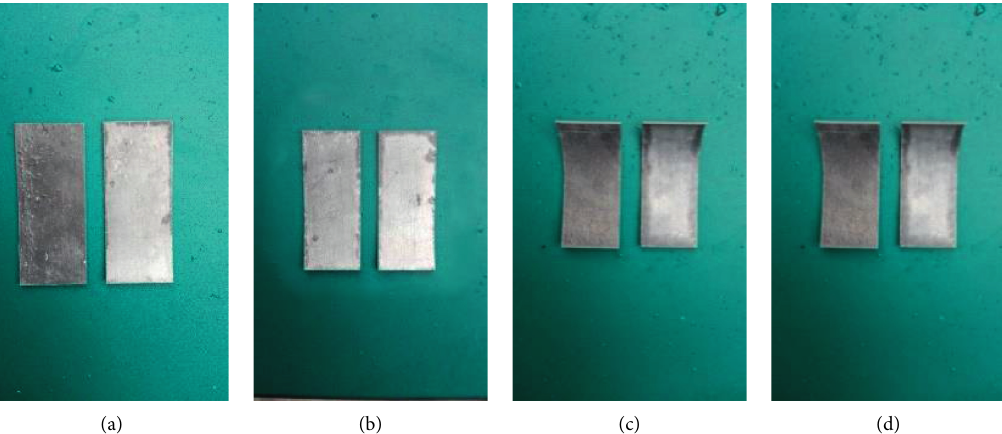
Figure 8: Brazed (4343/3003/6111/3003) clad sheets annealed at 410 ° C (left)/360 ° C (right) as function of rate of reduction: (a) 10%, (b) 20%, (c) 30%, and (d) 40%.